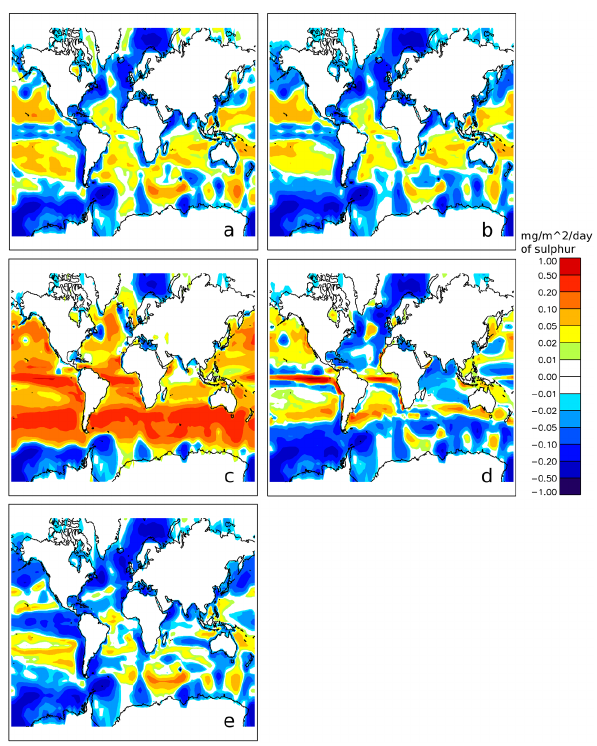
Fig. 3. Difference in DMS flux relative to the Kettle and An- dreae (2000) climatology (CLIM1) for (a) CLIM2 Sim´o and Dachs (2002) in PlankTOM5, (b) CLIM3 Vallina and Sim´o (2007) in PlankTOM5, (c) CLIM4 Anderson et al. (2001) in Diat-HadOCC (d) CLIM5 Sim´o and Dachs (2002) in Diat-HadOCC, (e) CLIM6 Vogt et al. (2009) in PlankTOM5. Differences in DMS flux are also summarised in Fig.